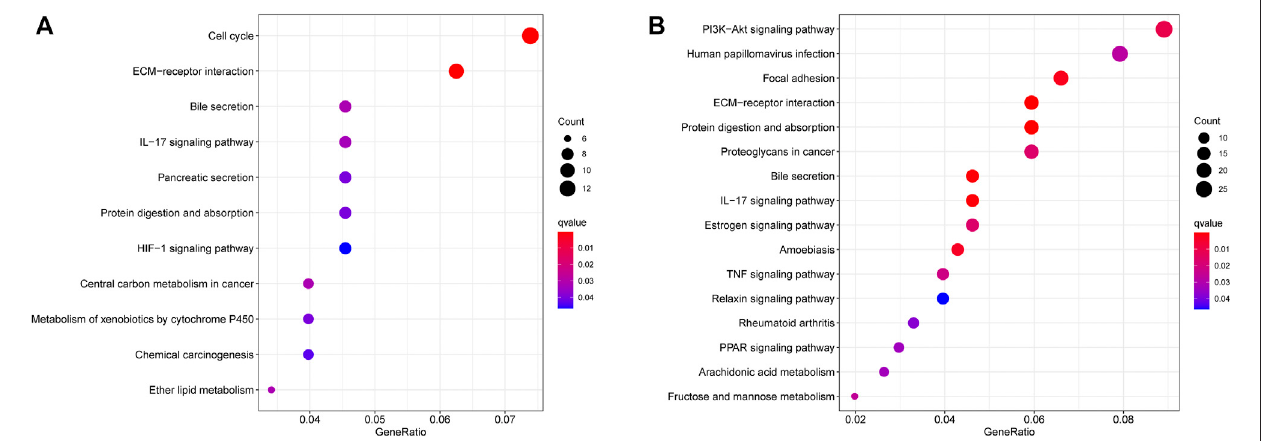
FIGURE 7 | The signi fi cant KEGG pathways in the TCGA cohort (A) and ICGC cohort (B) are